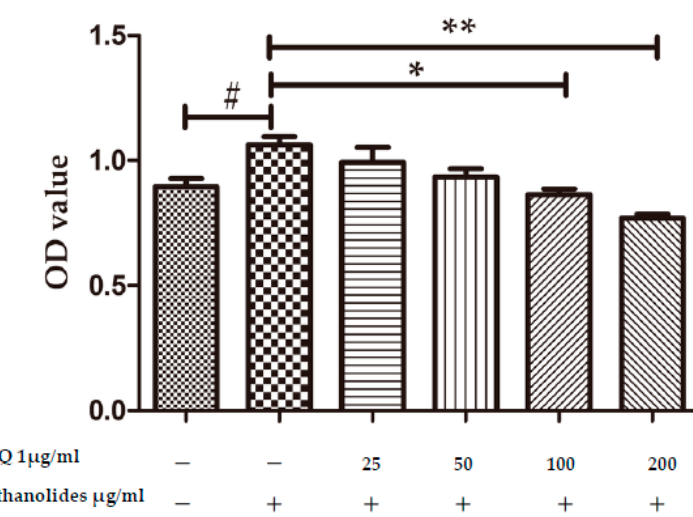
Figure 7. Effects of withanolides on HaCaT cell proliferation. HaCaT cells were treated with various doses of withanolides (0, 25, 50, 100 and 200 µ g / mL) in the presence or absence of 1 µ g / mL IMQ for 24 h. The optical density (OD) values were measured by the CCK-8 assay (mean ± SD, n = 3). # p < 0.05 vs. cell control group, * p < 0.05 vs. IMQ-treated group, ** p < 0.01 vs. IMQ-treated group.